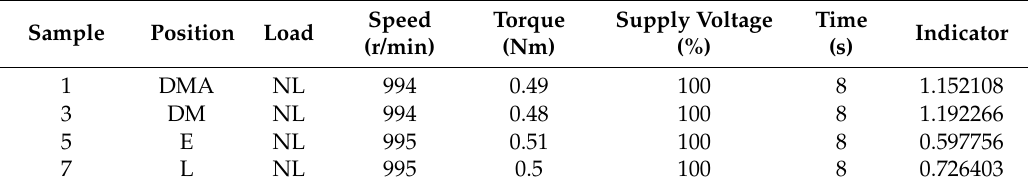
Table 8. Results of the indicatorin the frequency domain based on Equations (4) and (5) for the data of the experiments with the healthy motor at steady state.